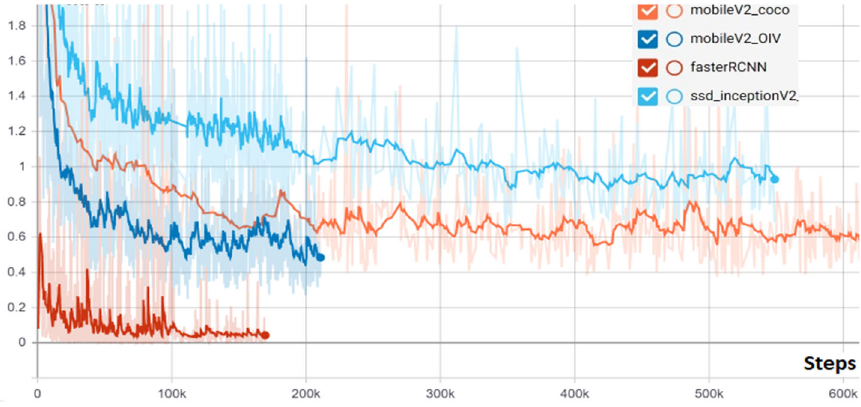
Figure 7. Classification losses for the object detectors.